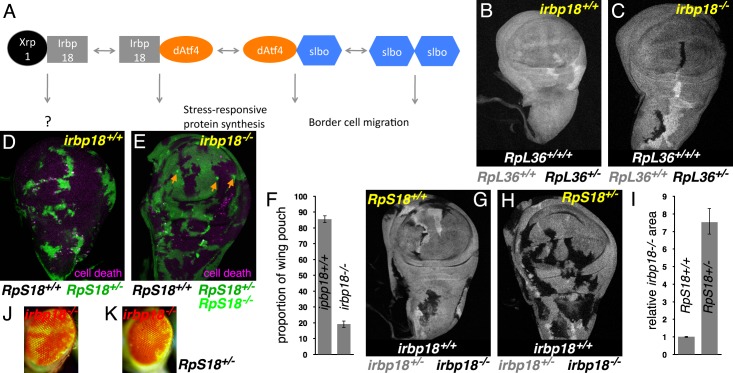
Xrp1 and related bZip proteins in cell competition.(A) Known dimers of Drosophila C/EBP –class bZip proteins and their potential functions. (B,C) Mitotic recombination in RpL36+/+ wing discs (grey) generates clones of RpL36+/+/+ cells (light grey) and reciprocal clones of RpL36+/- cells (black, lacking beta-Gal labeling). RpL36+/- clones that did not survive in the irbp18+/+ background (B) always survived in the irbp18-/- background (C). (D,E) Mitotic recombination in RpS18+/- wing discs (green) generates clones of RpS18+/+ cells (black,)lacking GFP expression. In the irbp18+/+ background (D) these have a growth and competitive advantage and come to dominate wing disc territory, eliminating remaining RpS18+/- cells by cell death (anti-active caspase DCP1 labeling in magenta). RpS18+/+ cells had less advantage in the irbp18-/- background (E). In addition, reciprocally recombinant RpS18-/- cells survived as small clones (bright green, eg arrows in E). (F) Quantitative comparison of RpS18+/+ clone growth in irbp18+/+ and irbp18-/- backgrounds. Wing pouch areas were the same in irbp18+/+ and irbp18-/- backgrounds (p=0.191, two-tailed t-test), but the RpS18+/+ fractions were not (p<0.0001, two-tailed t-test). Data derived from measurements of 4 irbp18+/+ discs and five irbp18-/- discs. (G,H) Mitotic recombination of the irbp18 locus in the RpS18+/+ and RpS18+/- backgrounds. Reciprocal clones of RpS18+/+ irbp18+/+ and RpS18+/+ irbp18-/- cells grew comparably (G) whereas clones of RpS18+/-irbp18-/- cells expanded at the expense of RpS18+/-irbp18+/- cells and RpS18+/-irbp18+/+ cells (H). (I) Quantification of growth in RpS18+/- and RpS18+/+ wing discs (eg panels G,H). irbp18-/- clone area was compared to reciprocal irbp18+/+ controls. Probability that clone areas are the same in the RpS18+/+ and RpS18+/- backgrounds = 1.4 × 10−9 (2-tailed t-test with unequal variances). Data derived from measurements of 7 RpS18+/+ discs and 9 RpS18+/- discs. (J) irbp18-/- clones (pigmented) contributing to the adult eye. (K) irbp18-/- clones (pigmented) occupy nearly all the RpS18+/- eye. Genotypes B) hsFlp/M(1)Bld; P[RpL36+ w+] arm-LacZ FRT80B/FRT80B. C) hsFlp/M(1)Bld; P[RpL36+ w+] arm-LacZ FRT80B/irbp18f05006 FRT80B. D) y w hs-FLP; FRT42D ubi-GFP M( f05006)56F/FRT42D. E) y w hs-FLP; FRT42D ubi-GFP M(2)56F/FRT42D; irbp18f05006/irbp18f05006. G) y w hs-FLP; +/+; irbp18f05006 FRT80B /arm LacZ FRT80B. H) y w hs-FLP; FRT42D ubi-GFP M(2)56F*/+; irbp18f05006 FRT80B/arm LacZ FRT80B. J) y w ey-FLP/Y; FRT42D ubi-GFP/+; irbp18f05006 FRT80B/FRT80B K) y w ey-FLP/Y; FRT42D ubi-GFP RpS18/+; irbp18f05006 FRT80B/FRT80B. Note that the irbp18f05006 allele includes a w+ element that is responsible for most of the eye pigmentation.Figure 1—source data 1.Measurements of clone and wing pouch sizes corresponding to Figure 1F.Figure 1—source data 2.Clone size data corresponding to Figure 1I.